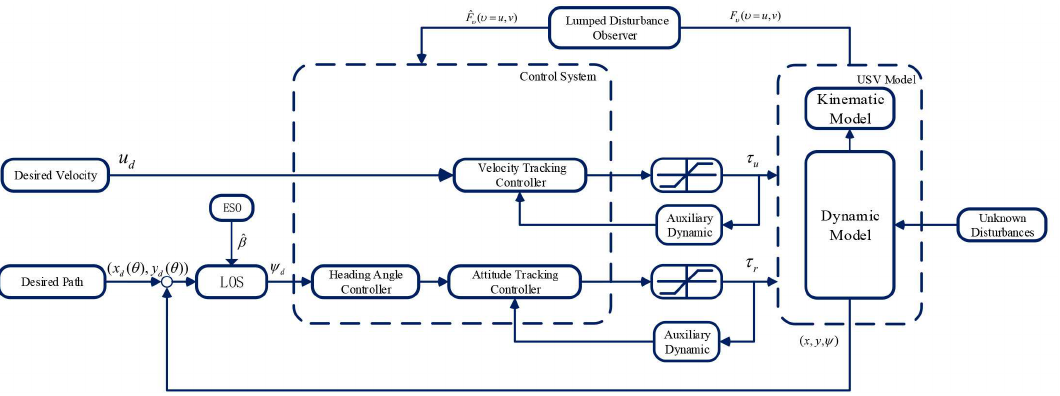
Figure 2. The Block Diagram of The Path Following